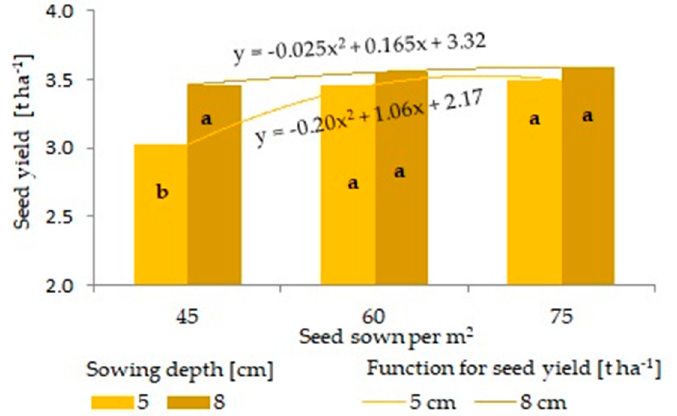
Figure 9. Seed yield in 2011 (SDH × SDY). Different letters indicate significant differences between factors (Tukey’s multiple range test).